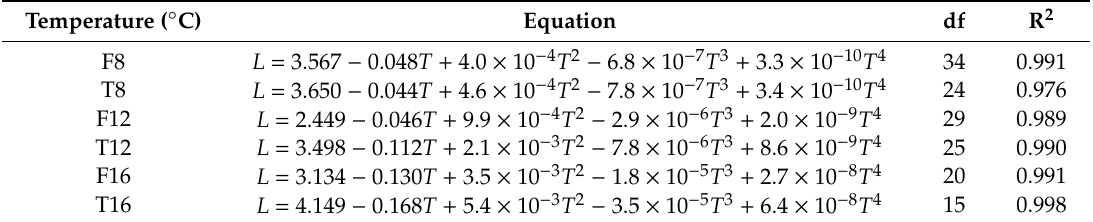
Table 2. Curve fitting equation, degrees of freedom (df), and coefficients of determination (R 2 ) of the relationship between the body length ( L ) (mm) of A. grahami larvae and the time after hatching ( T ) (h) at three fluctuating temperatures 6–12 °C (F8), 10–16 °C (F12 °C), 14–20 °C (F16 °C), and constant